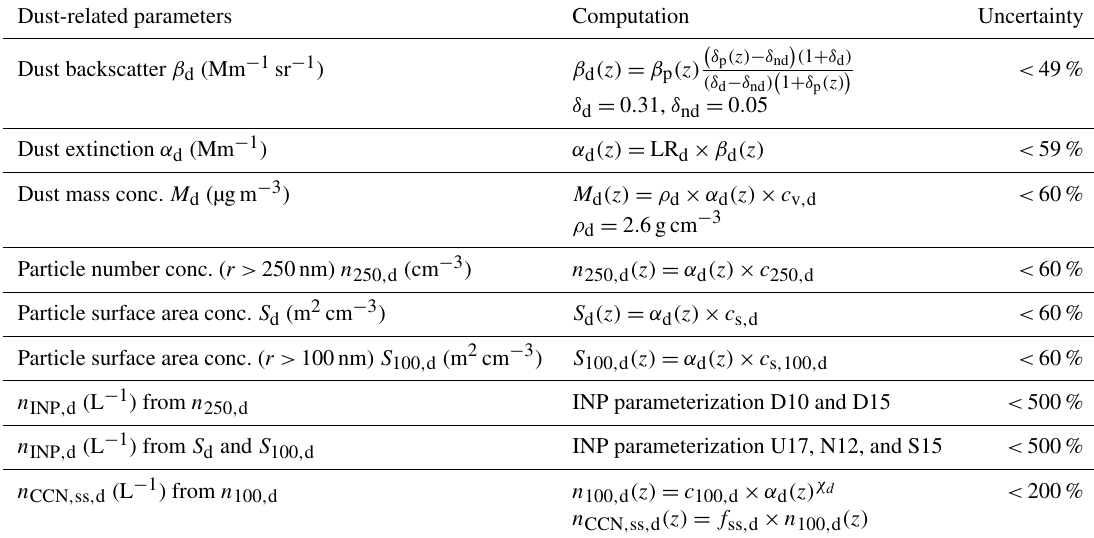
Table 1. Dust-related parameters of optical properties, cloud condensation nuclei, and ice-nucleating particles calculated by the POLIPHON method (Tesche et al., 2009; Marinou et al., 2019; Ansmann et al., 2019b). D10, D15, U17, N12, and S15 refer to the respective INP parameterizations in DeMott et al. (2010), DeMott et al. (2015), Ullrich et al. (2017), Niemand et al. (2012), and Steinke et al. (2015). The subscript “ss” denotes the water supersaturation. The uncertainties are provided based on using the CALIOP level-2 aerosol profile product for INPC and CCNC